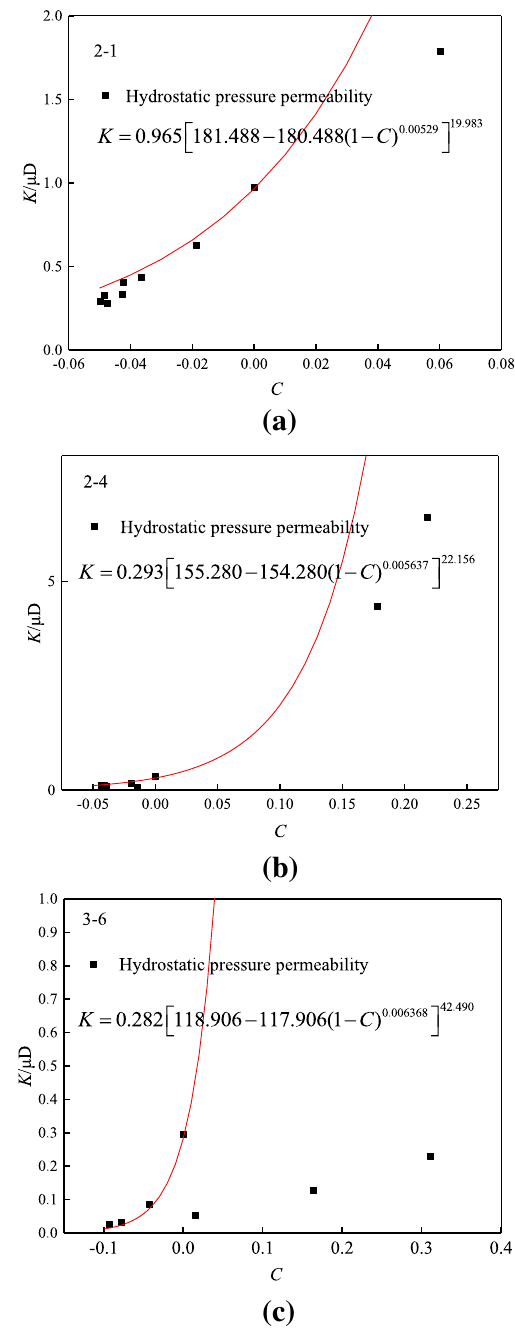
Fig. 14 The relationship between permeability K and compression parameter C : a specimen 2–1, b specimen 2–4, c specimen